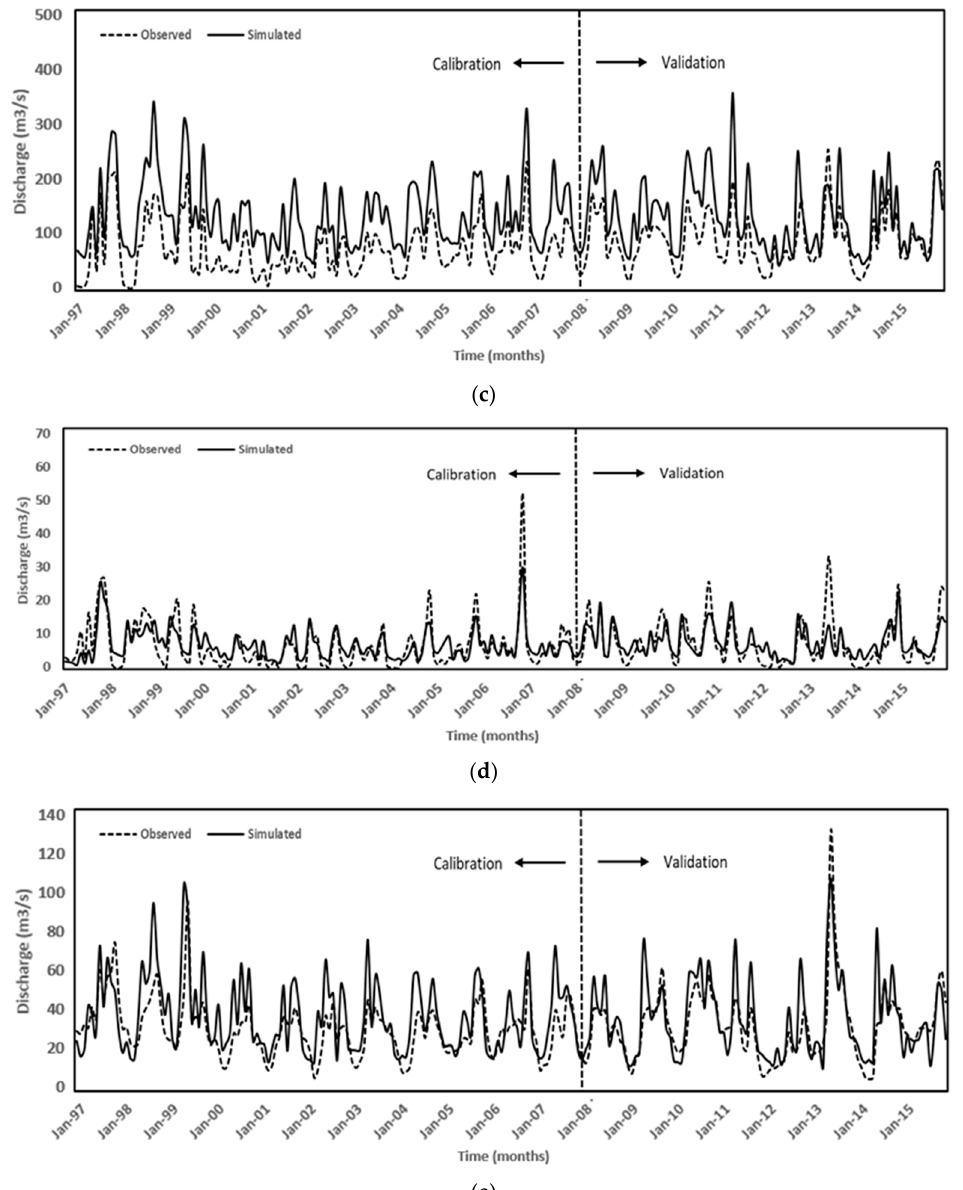
Figure 6. Monthly simulated and observed streamflow discharge for calibration at Deraniyagala: ( a ) Deraniyagala; ( b ) Hanwella; ( c ) Glencorse; ( d ) Holombuwa; ( e ) Kithulgala.